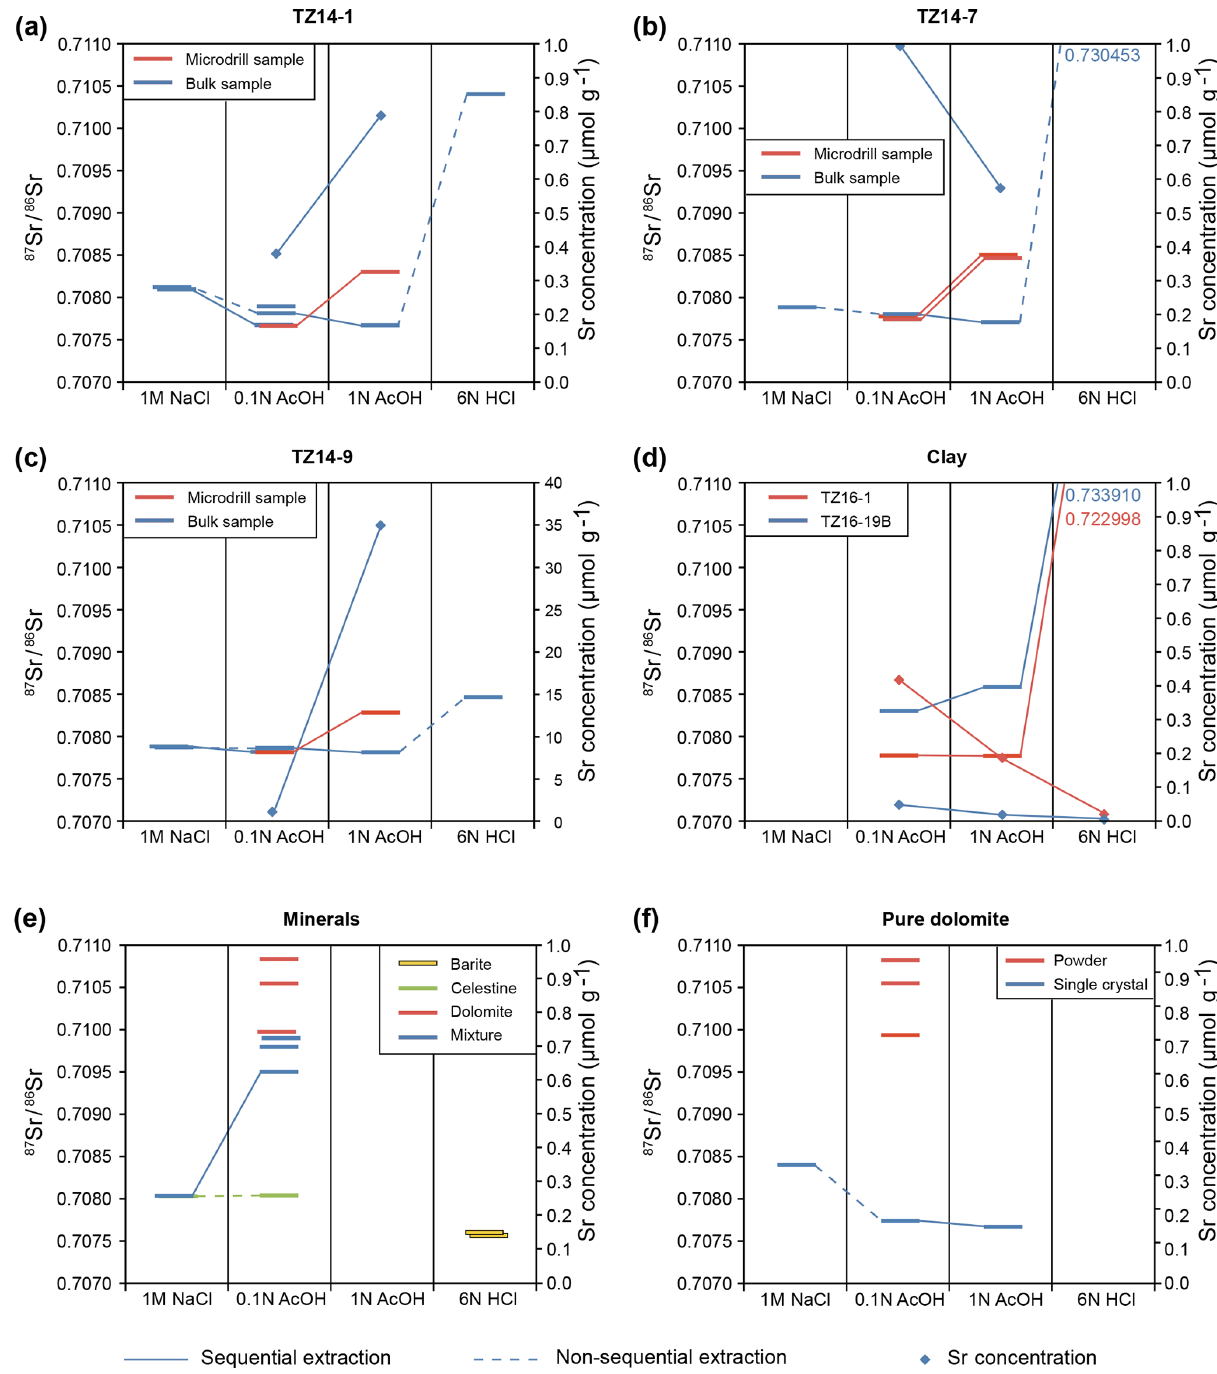
Figure 10. Sr-isotope ratios and Sr concentrations measured in sequential and non-sequential extractions of dolomite and different control minerals. (a–c) Dolomite samples of the Travenanzes Fm. show consistently low Sr-isotope values (below 0.708000) in the 0.1N acetic acid fraction and very high values in the HCl fraction. The values in the 1N acetic acid fraction are higher in the microdrilled samples, perhaps due to partial leaching of residual clay minerals. In bulk samples values are low, while concentrations indicate still abundant Sr, presumably from the dolomite phase. (d) Claystone samples show generally elevated Sr-isotope values (compared to the dolomite samples) and lower concentrations. Low Sr-isotope values and higher concentrations in the acetic acid fractions of sample TZ16-19B could be due to traces of carbonate in the sample. (e, f) Pure control materials, including barite, celestine, dolomite, and a mixture of these minerals show clear separation of the three fractions. Sr-isotope values in dolomites show some scattering, probably due to inhomogeneities in the powder and the single crystals. The 2 σ uncertainties are smaller than the symbol